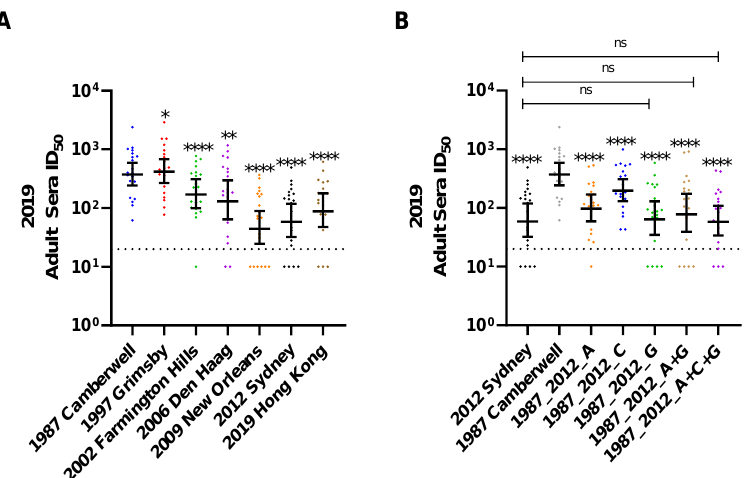
Figure 4. Variant and antigenic site-specific nAb responses in contemporary adult sera. Sera from adults collected in 2019 ( n = 20) were evaluated for nAb titer to a panel of GII.4 variants ( A ) or antigenic site chimera VLPs comprised of GII.4 2012 Sydney antigenic sites in the backbone of GII.4 1987 Camberwell ( B ). Only samples with titer ≥ 50 to either GII.4 2012 Sydney or 1987 Camberwell were included in the analysis to exclude subjects who are genetically resistant to GII.4 infection. Y-axis: reciprocal of the serum dilution at 50% inhibitory dose. Marker: individual adult. Line: geometric mean titer. Error bars: 95% confidence intervals. Dashed line: limit of detection. * p = 0.02, ** p = 0.001, **** p < 0.0001 compared to GII.4 1987 Camberwell.